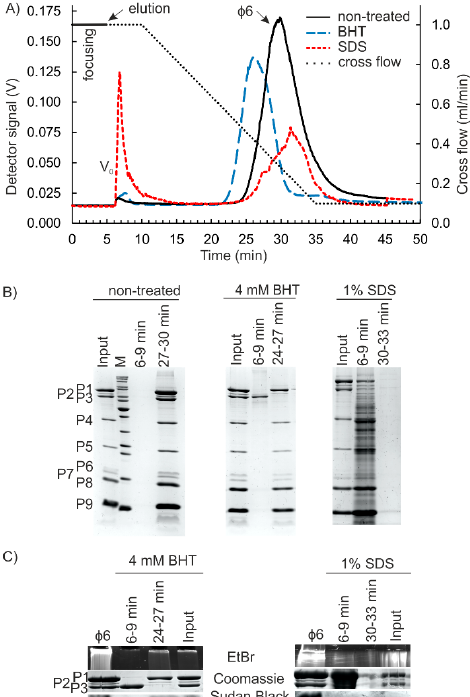
Figure 2. BHT- and SDS-treatment of φ 6 virions. ( A ) AF4 fractograms for BHT-, SDS-, and non-treated φ 6. Cross-flow elution gradient is shown with a dashed line (right y-axis). Detector signal intensity was measured at 260 nm in volts (V) (left y-axis). V 0 is the void peak. ( B ) Protein content of the peak fractions was compared to the corresponding input samples. Equal volumes of fractions representing the peak maxima were analyzed. φ 6 proteins are indicated on the left. M shows the migration pattern of Thermo Scientific PageRuler Unstained Protein Ladder #26614 (10 to 200 kDa). ( C ) Presence of lipids (Sudan Black B staining) and RNA (EtBr staining of the stacking gel) in the AF4 fractions and the corresponding input samples of BHT- and SDS-treated φ 6. Coomassie stain for P1–P3 proteins is shown for